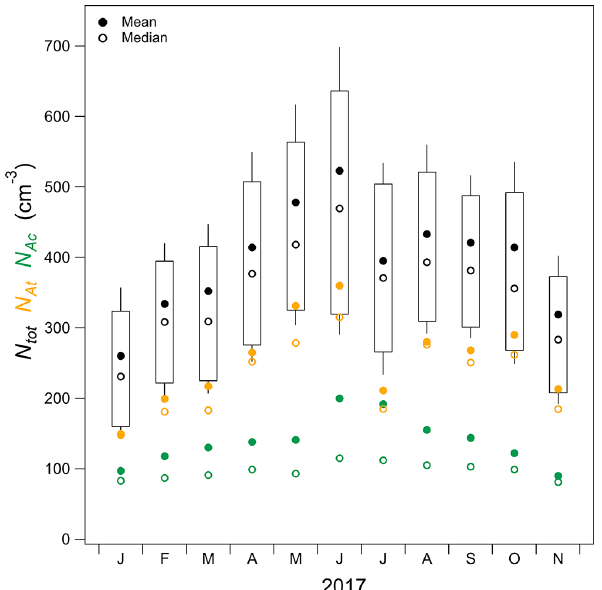
Figure 1. Box and whisker plot of monthly submicron aerosol num- ber concentrations (box bottom at 25%, box top at 75%, whisker bottom at 10%, and whisker top at 90%). Mean (circles) and me- dian (open circles) of total number concentration (black), number of Aitken (yellow), and accumulation (green) modes.